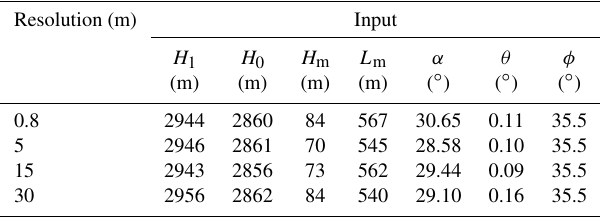
Table 4. Parameters obtained using images with different resolu- tions. H 1 is the elevation of the lake level, H 0 is the elevation of the dam bottom, H m is H 1 minus H 0 , L m is the length of the dam that can be observed in the image, α is the slope angle of the landslide surface, θ is the inclination angle of the riverbed and φ is the angle of